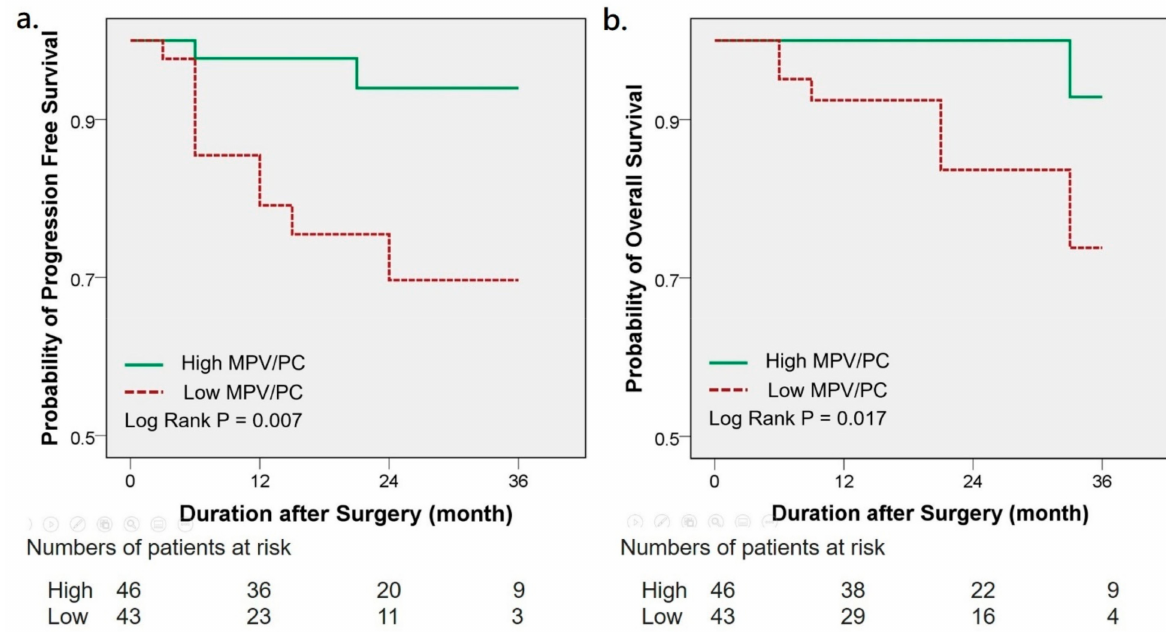
Figure 3. Kaplan–Meier analysis of progression-free survival ( a ) and overall survival ( b ) in RCC patients with high and low MPV/PC ratio. RCC: renal cell carcinoma; MPV/PC: mean platelet volume/platelet